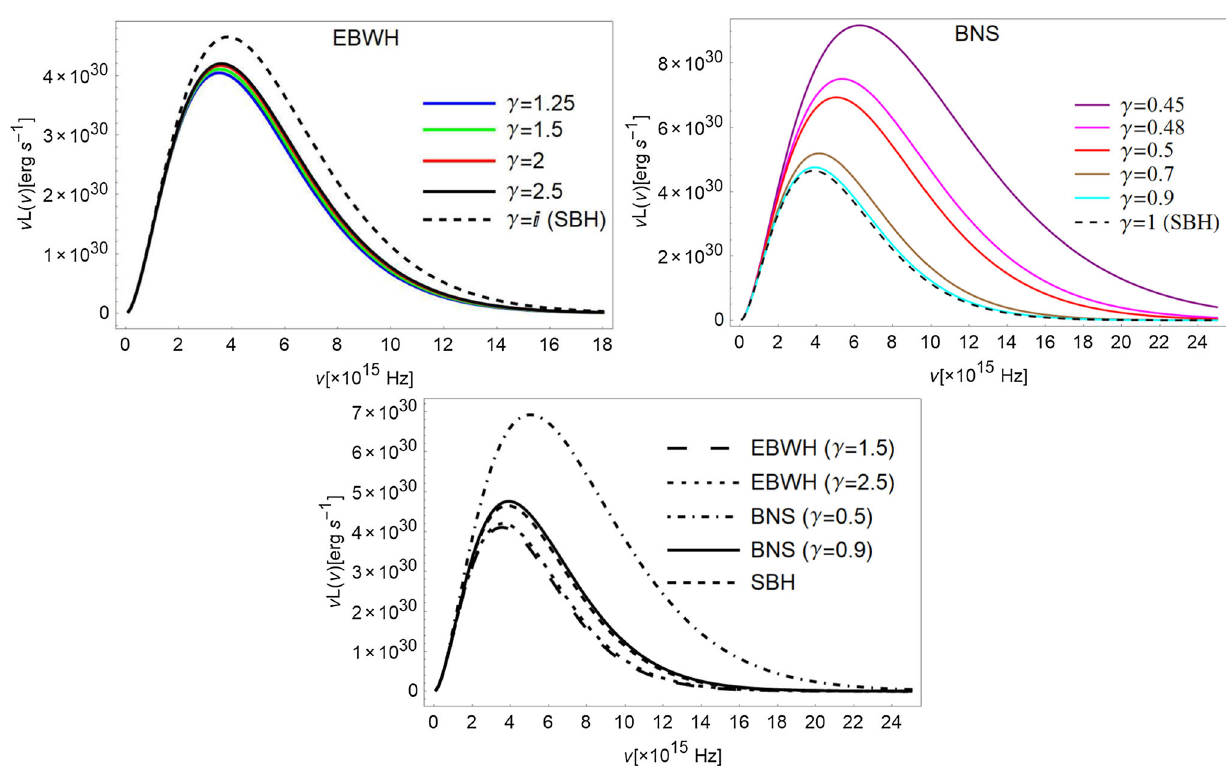
Fig. 7 The emission spectra υ L (υ) of the accretion disk with inclination i = 0 ◦ for EBWH, BNS and SBH for different values of γ